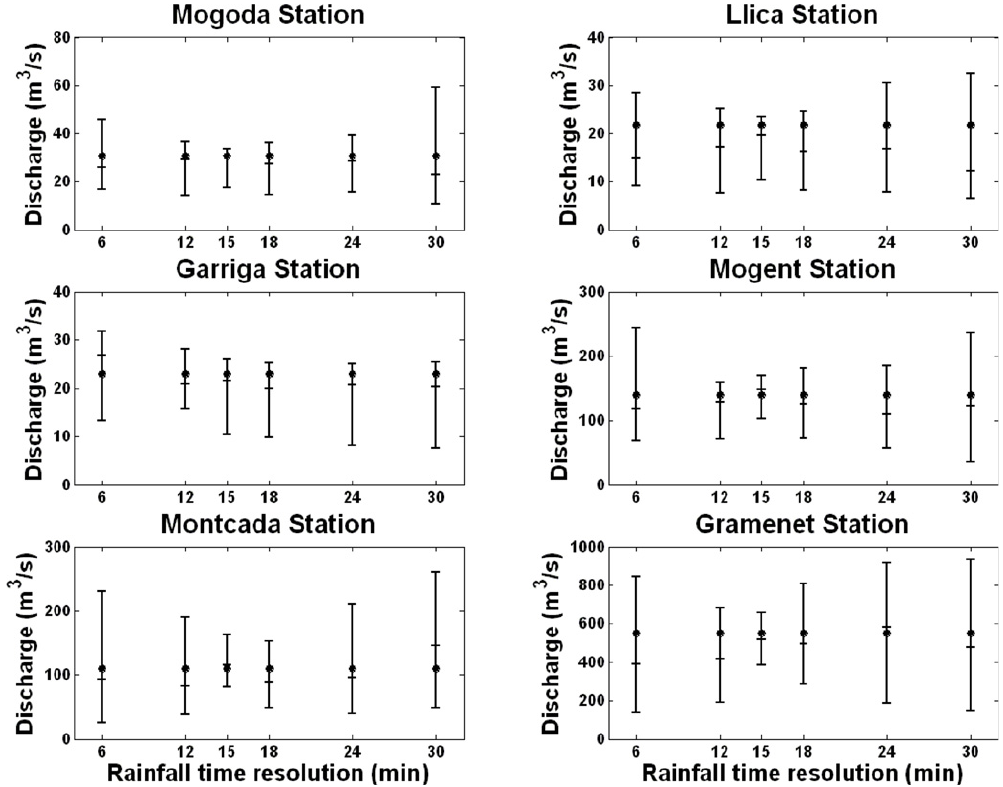
Fig. 13. Validation results for the peak discharge as a function of time resolution, at all station locations. The observed peak discharge is plotted as a solid circle, 5% and 95% percentiles are plotted as vertical bars and the median is plotted as a horizontal